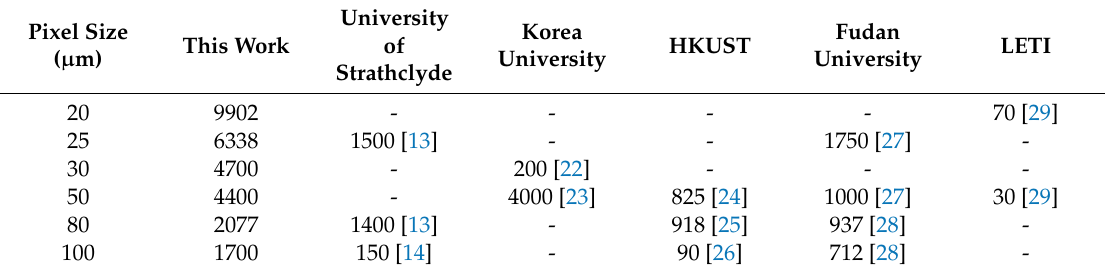
Table 2. Current density comparison under a 5V forward bias (units: A / cm 2